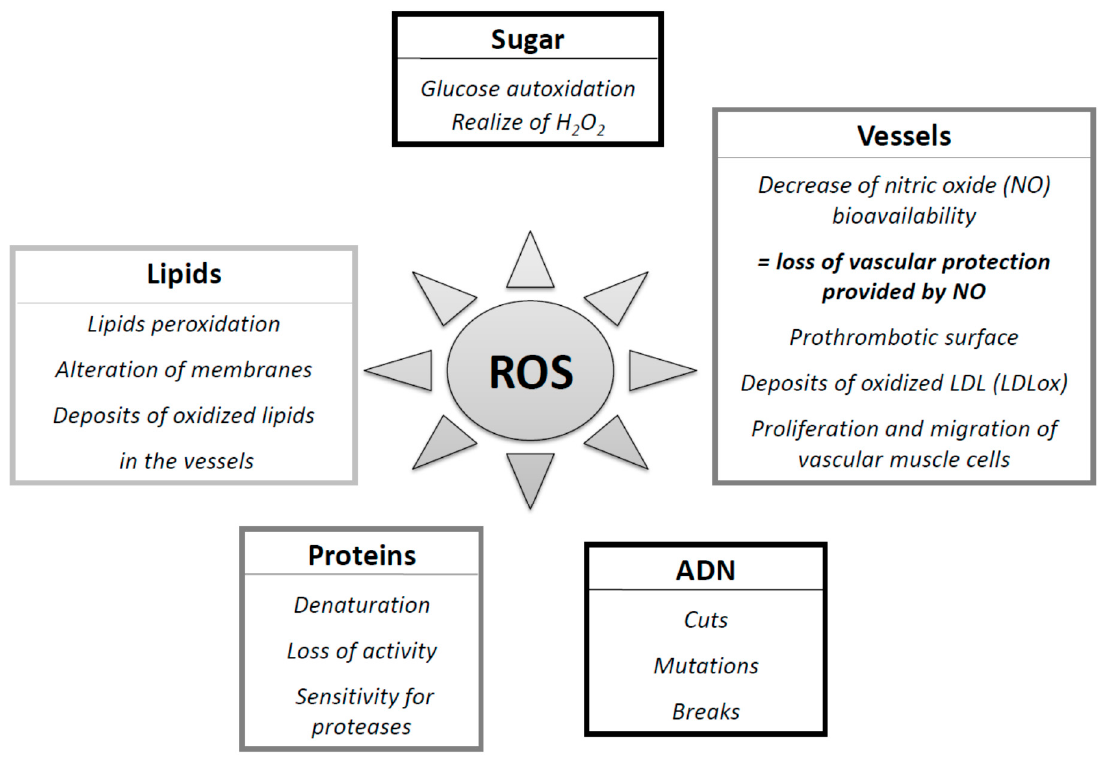
Figure 5. Reactive oxygen species (ROS) and complications. Impact of ROS on lipids, DNA, proteins, glucose, and vessels.